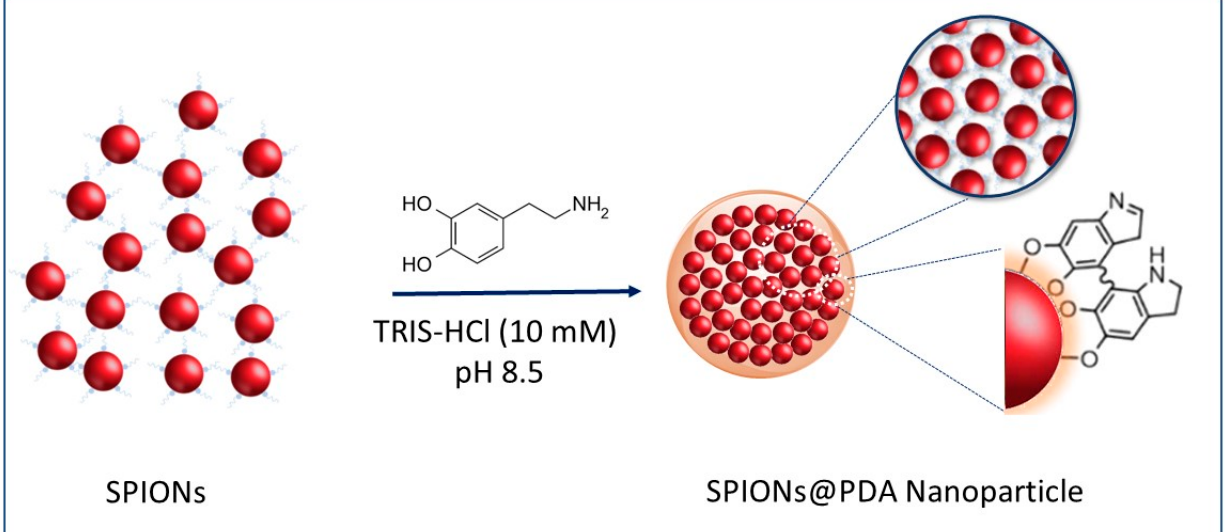
Figure 3. Representative sketch of the preparation of the SPION@PDA NPs.